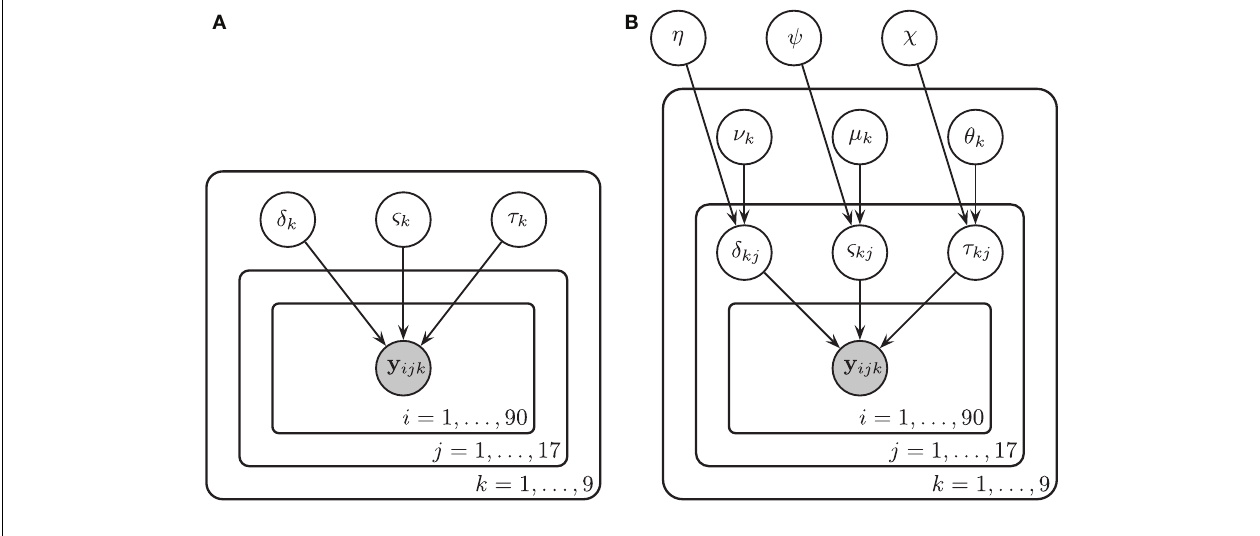
noise pair. In Model 2 , drift rates δ jk , diffusion coefficients ς jk , and non-decision times τ jk were assumed to vary over both conditions and participants. Each of these parameters are in turn assumed to be drawn from normal distributions with means that varied over conditions k and with variances that did not vary across